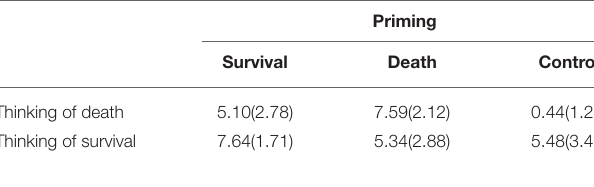
TABLE 4 | Descriptive data of thoughts of death and thoughts of survival in experiment 2.